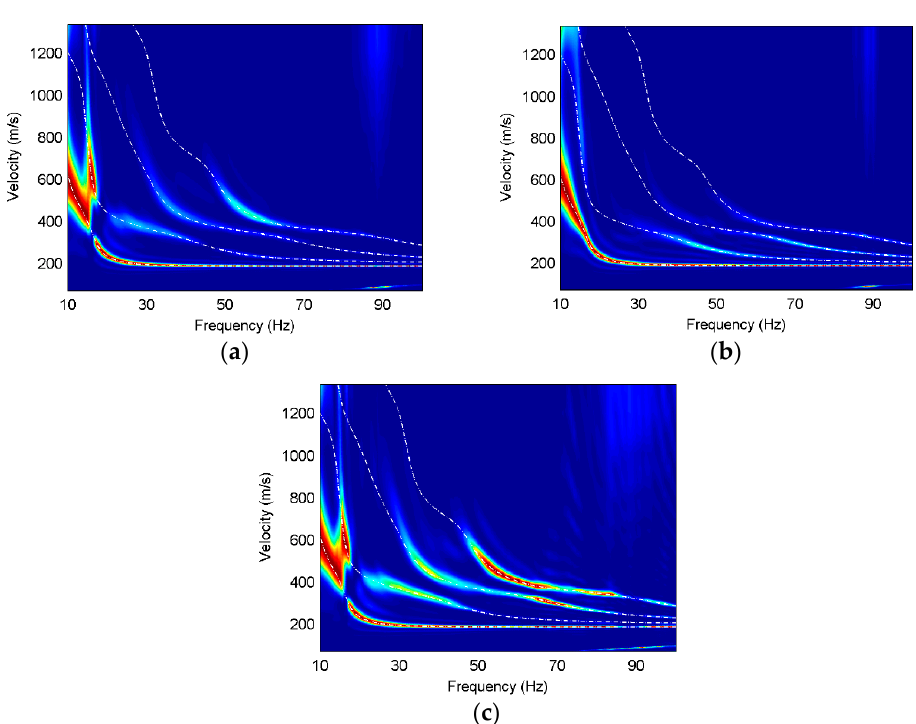
Figure 3. Dispersion images for Model 1, where the white dashed lines are the theoretical dispersion curves and the red color represents the maximum energy. ( a ) X component of Model 1; ( b ) Z component of Model 1; ( c ) R y component of Model 1.